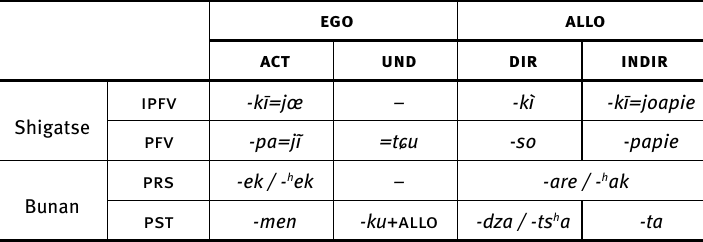
Table 7. Egophoricity and evidentiality in Shigatse Tibetan and Bunan ego